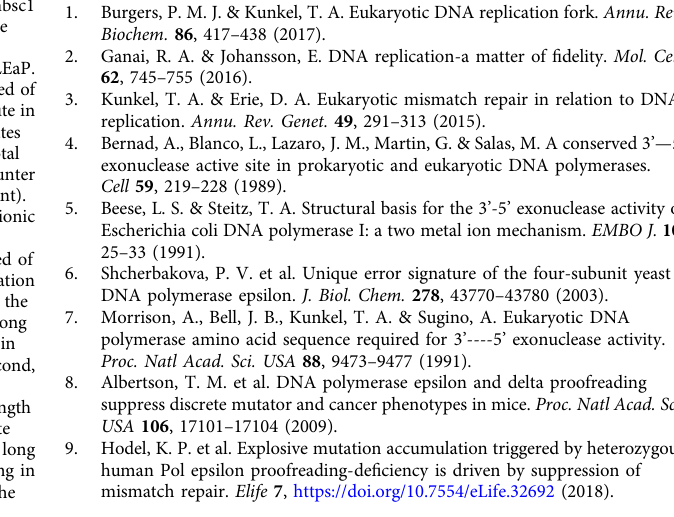
Supplementary Figure 1. The reactions were terminated by the addition of 20 μ L of 95% formamide, 20 mM EDTA, and 0.1% bromophenol blue, heated to 85°C,